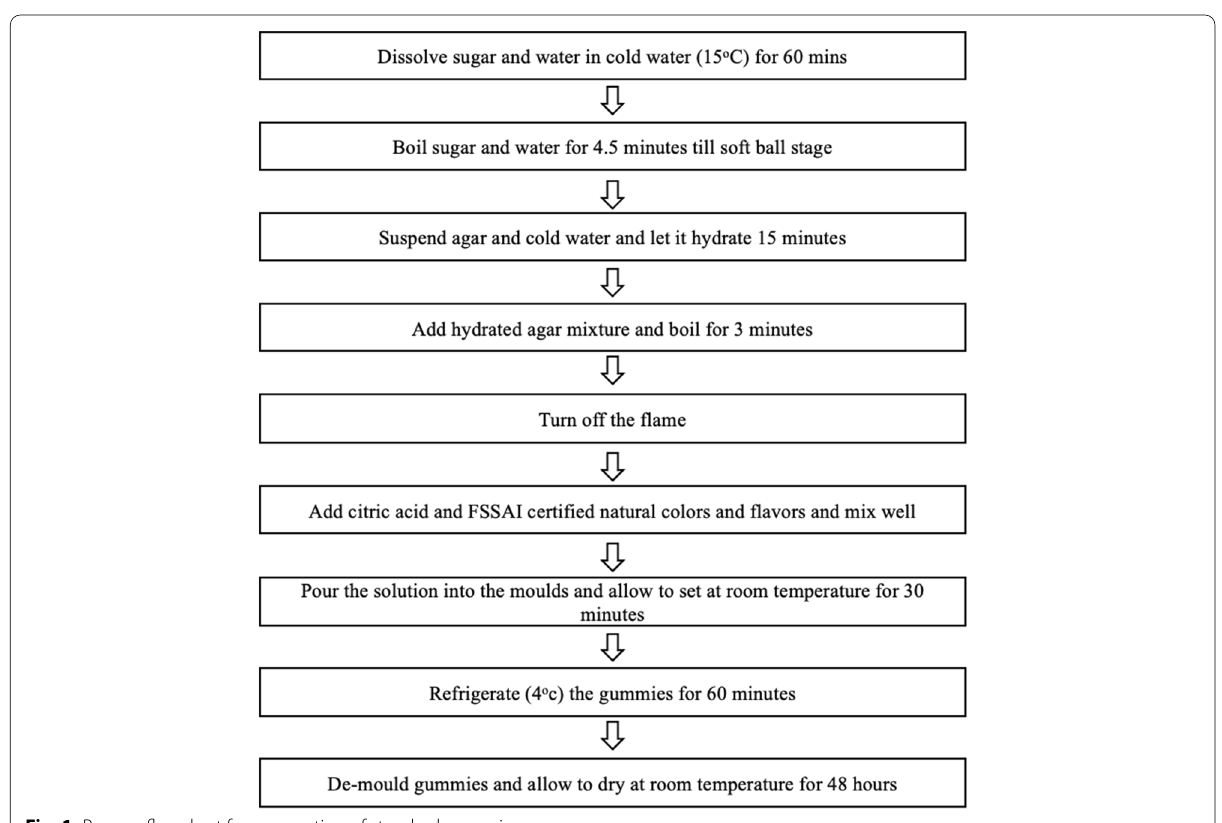
Fig. 1 Process flowchart for preparation of standard